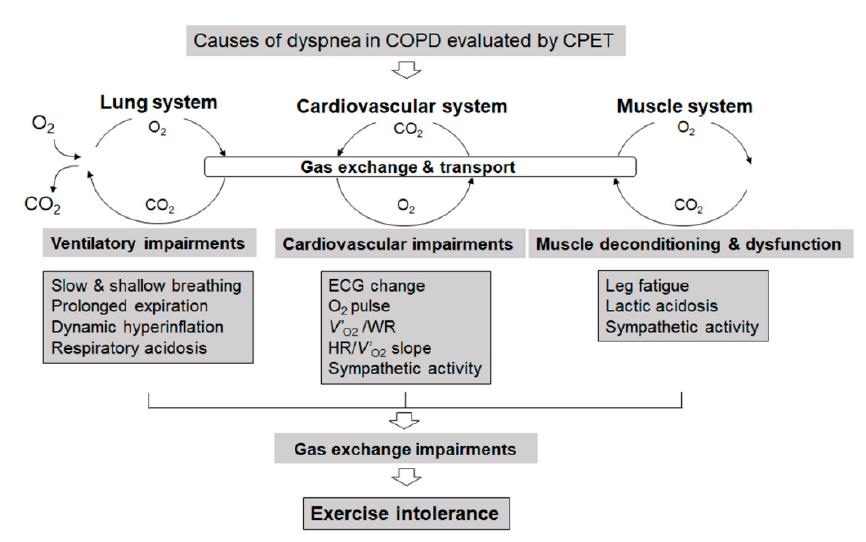
Figure 1. Schematic pathophysiologic pathway exertional dyspnea in chronic obstructive pulmonary disease. CO 2 : carbon dioxide; CPET: cardiopulmonary exercise testing; ECG: electrocardiogram; HR: heart rate; O 2 : oxygen; O 2 pulse: V’ O2 /heart rate; V’ O2 : oxygen uptake; WR: work rate. This is an original figure (no permission is required).